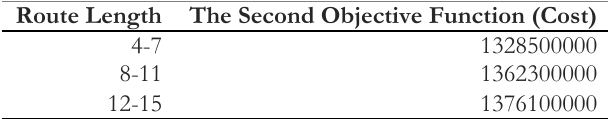
Table 13. Analysis of the effect of discharge route length on